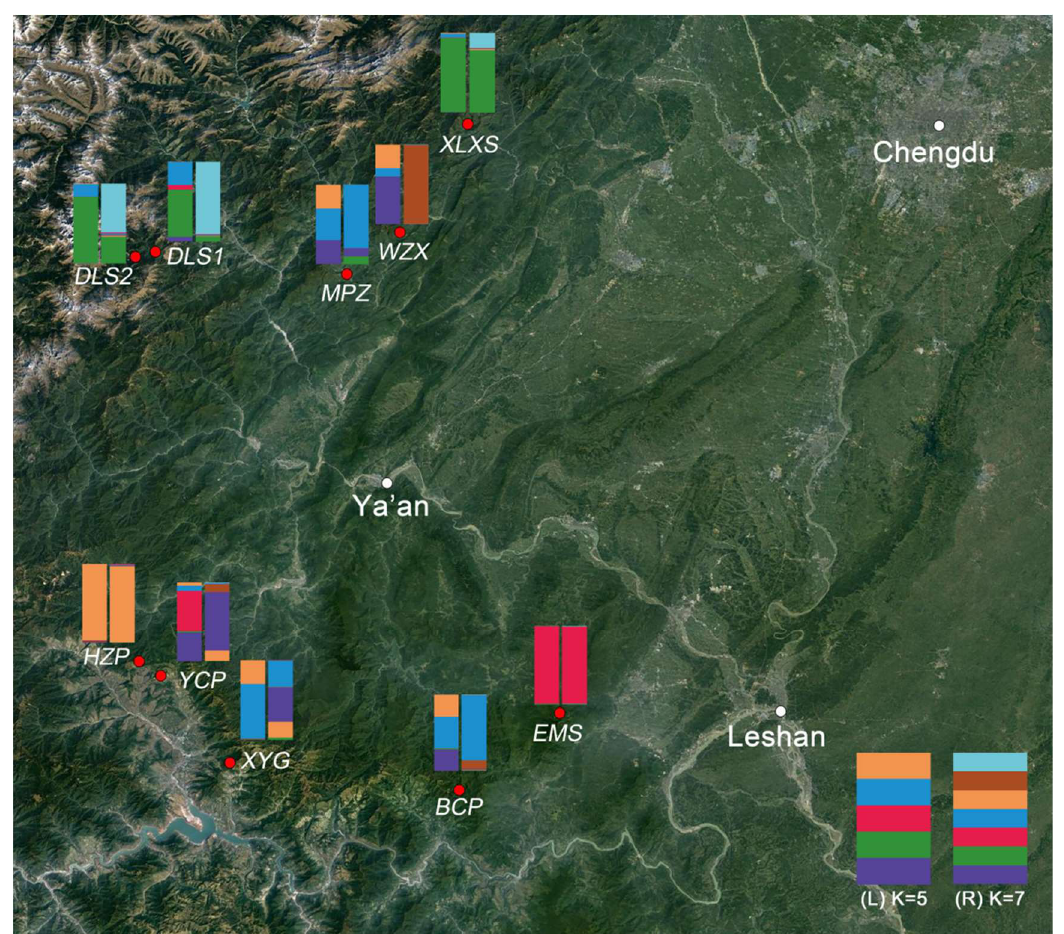
Figure 4. Geographical distribution of the plant materials. Red dots indicate the populations collected from southwestern Sichuan, China, and the white dots indicate the main cities. Colored bars show the mean proportions of cluster memberships of analyzed individuals in each of the ten O. serrulatus populations based on structure at K = 5 (left) and K = 7 (right).